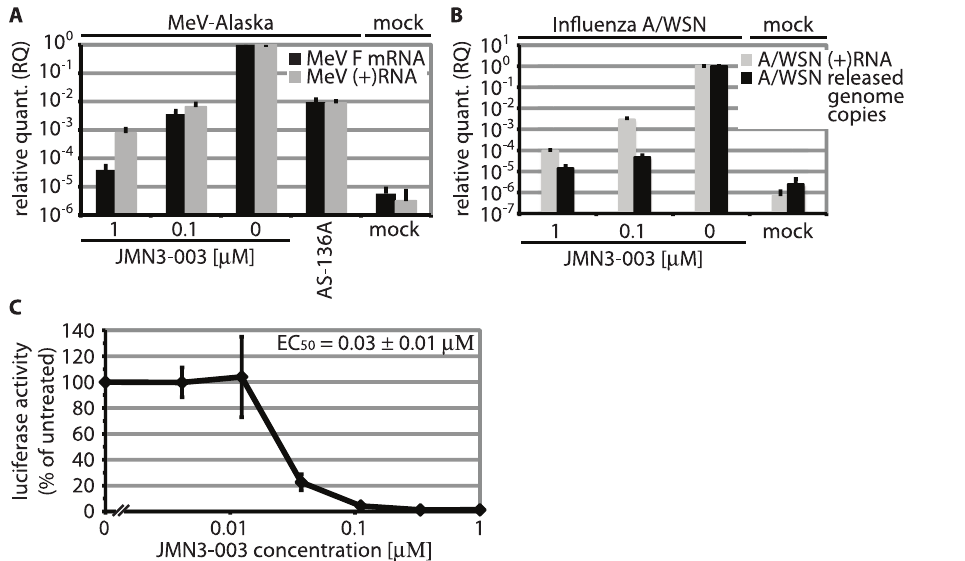
Figure 7. Compound JMN3-003 inhibits viral RNA synthesis. A ) Relative quantitations of MeV F mRNA and antigenome ( + RNA) levels after incubation of infected cells in the presence of compound for 40 hours. Samples were normalized for vehicle only (DMSO)-treated cells and DD C T values calculated using cellular GAPDH as reference. Mock samples remained uninfected. Averages of three independent experiments, assessed in triplicate each, 6 SD are shown. B ) Quantitation of influenza A/WSN segment seven antigenome ( + RNA) and of released progeny genomic RNA (genome copies) after incubation of infected MDCK cells in the presence of compound for 24 hours. For + RNA quantitation, samples were normalized and DD C T values calculated as outlined in (A). Released genome copies were quantified by TaqMan RT-PCR relative to an external standard, then normalized for vehicle-treated controls. Averages of four experiments, assessed in triplicate each, 6 SD are shown. C ) Luciferase reporter-based assessment of viral RdRp activity in the presence of JMN3-003. BHK-T7 cells transfected with plasmids encoding the MeV minireplicon reporter system were incubated in the presence of JMN3-003 or vehicle only for 36 hours. Values were normalized for luciferase activities found in vehicle (DMSO)- treated controls and represent averages of three experiments assessed in duplicate each 6 SD. doi:10.1371/journal.pone.0020069.g007 a host-directed antiviral based on several lines of evidence: I) antiviral activity is host cell species-dependent, indicating specific interaction with a distinct host factor rather than a viral component. Host cell-specific activity is incompatible with carbohydrate structures exposed on viral envelope glycoproteins that are targeted by antiviral lectins such as pradimicin A [62].